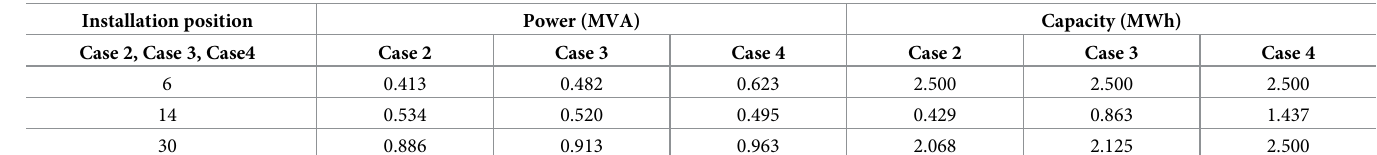
Table 4. Configuration results of